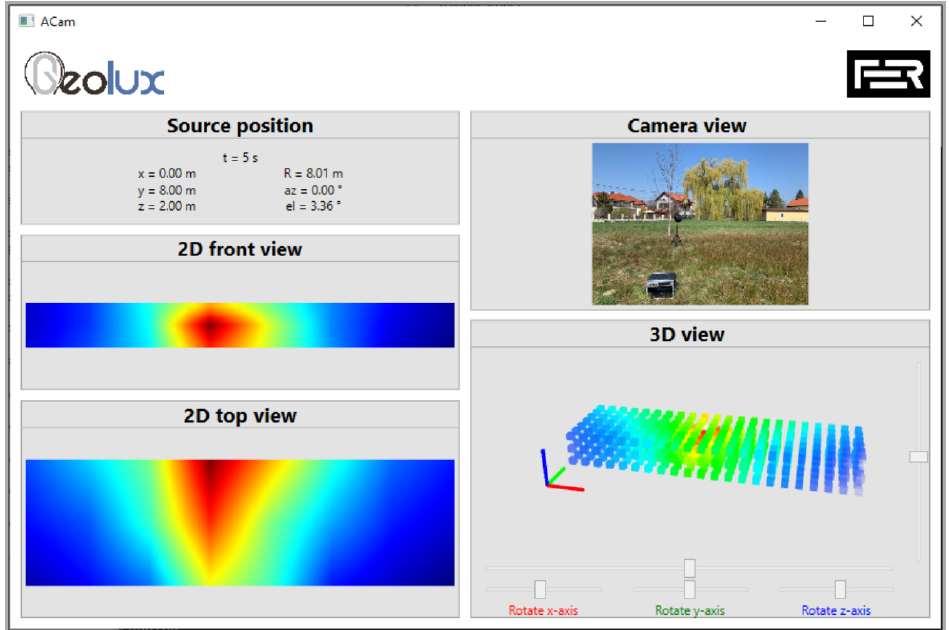
Figure 16. Measurements obtained with acoustic camera prototype.